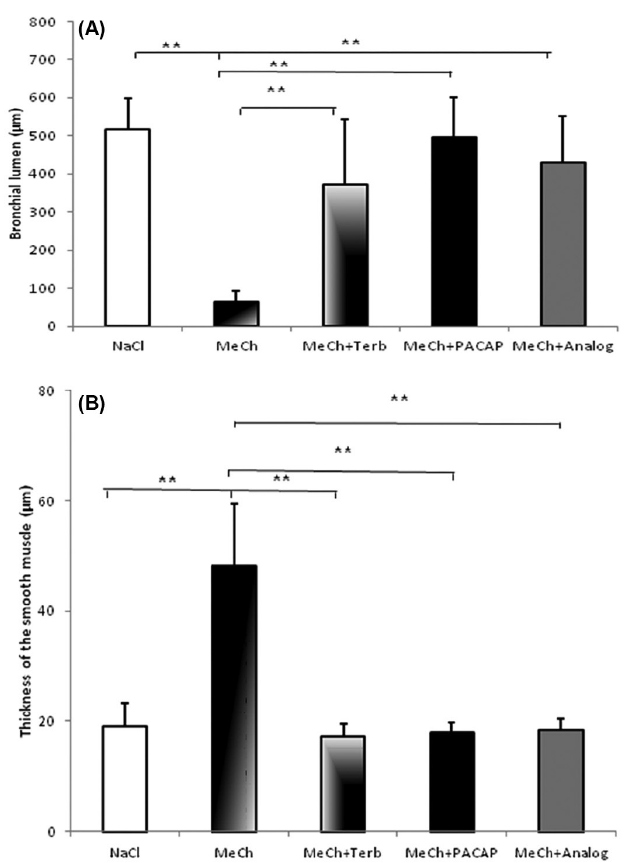
FIGURE 3 - Effect of terbutaline or PACAP on bronchial morphometry in lungs of rats challenged by metacholine (Mech). (A) Bronchial lumen diameter (B) bronchial smooth muscle (SM) layer thickness. Each value is the mean ± SD of 8 determinations. * p ≤ 0.05, ** p ≤ 0.01 between experimental